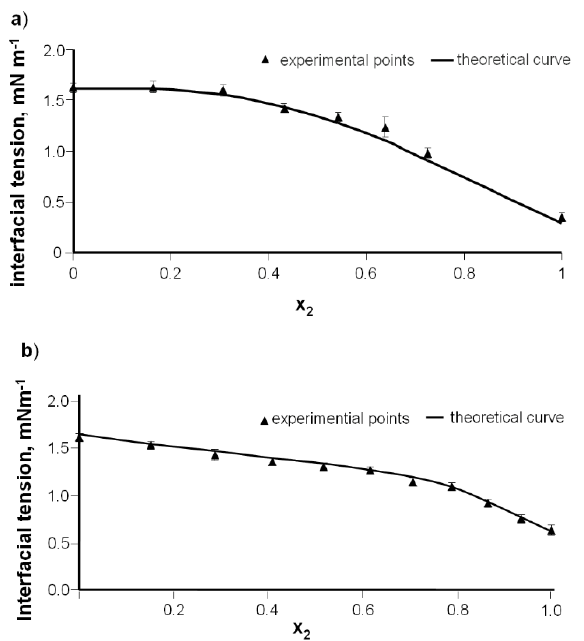
Figure 5. DPPC-diosgenin ( a ), and DPPC-diosgenin acetate ( b ) interfacial tension values vs. mole fraction x 2 (component 2); the theoretical values are marked by curves and the experimental values by